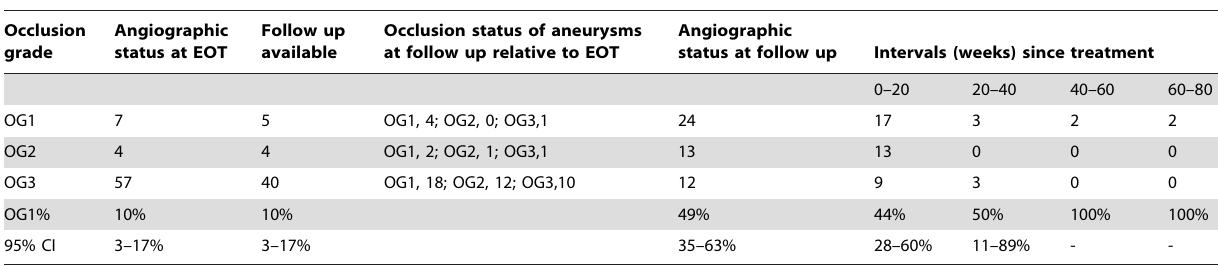
Table 3. Angiographic outcomes for the aneurysms treated with SFD.